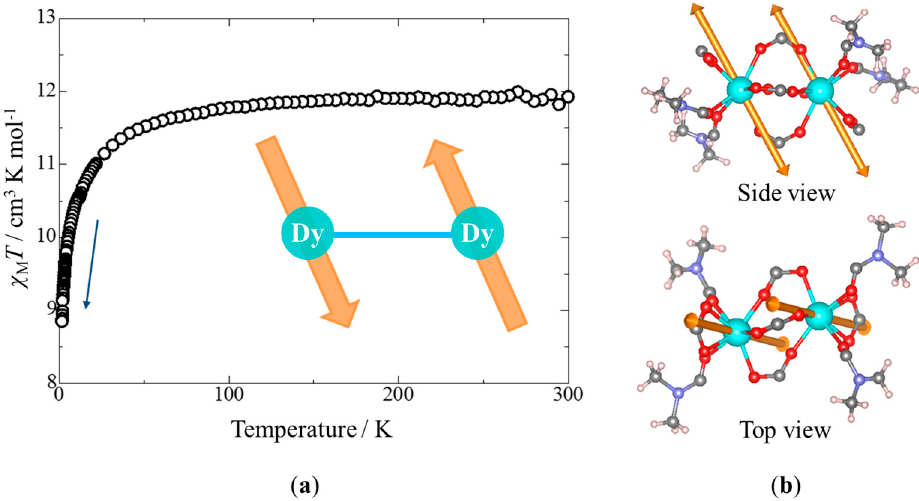
Figure 5. ( a ) χ M T - T plots for 1 and ( b ) drawings of the magnetic easy axes of dinuclear cluster in 1 calculated by using Magellan magnetic software. Inset of ( a ) is antiferromagnetic spin alignment of the dinuclear clusters in 1 .